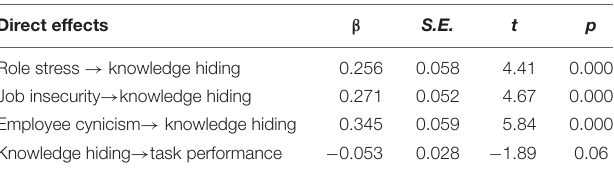
TABLE 3 | Direct and indirect